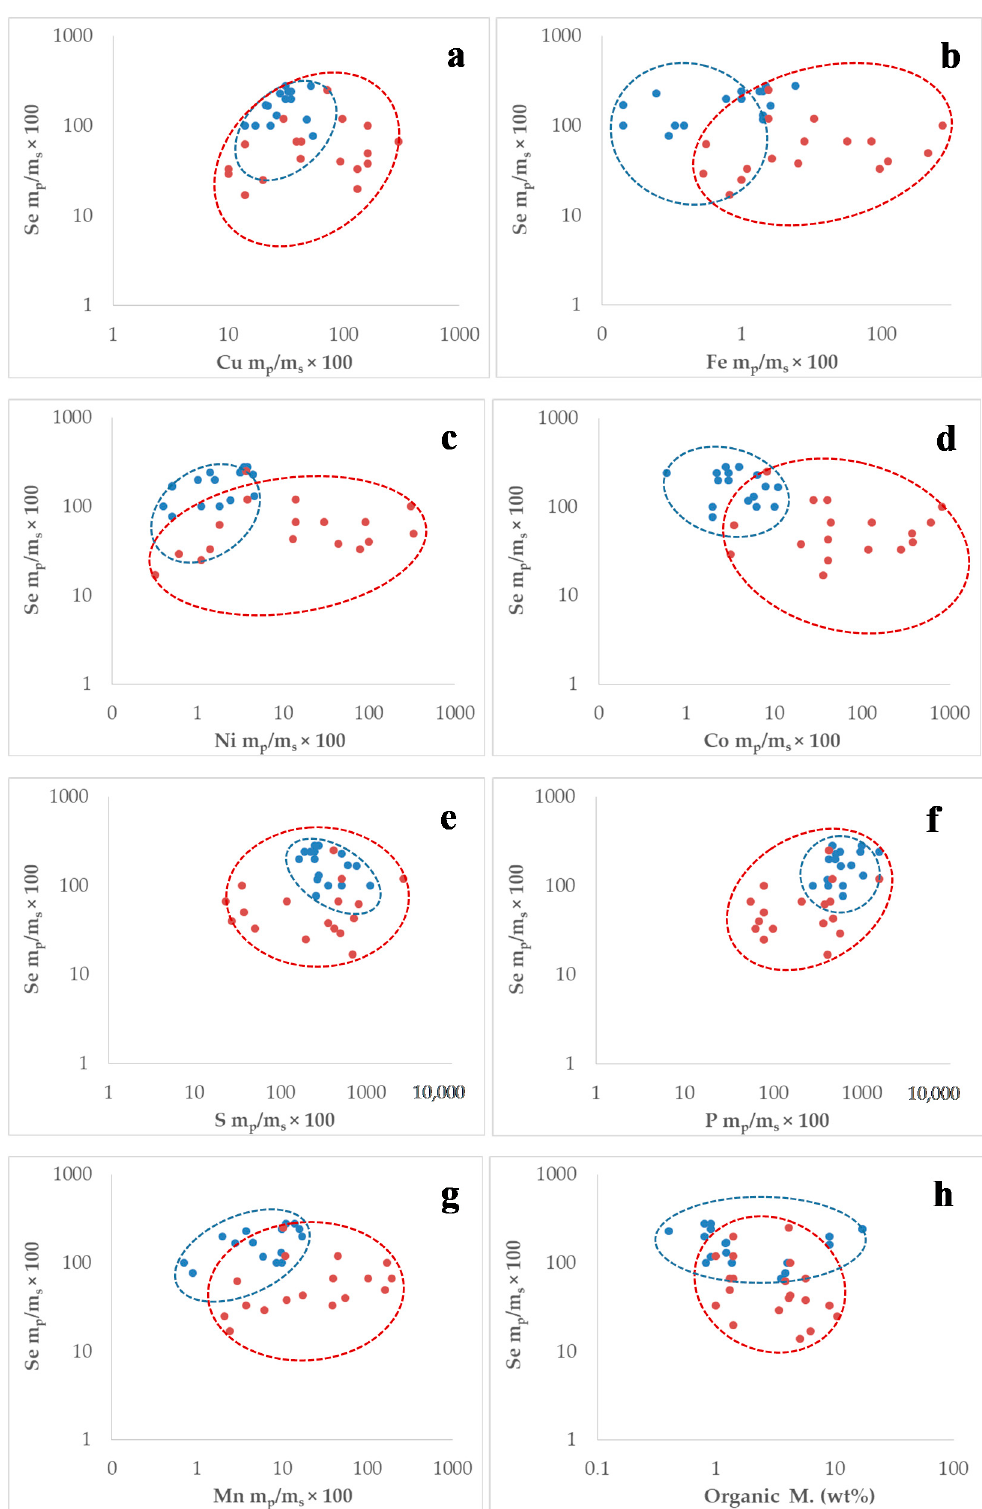
Figure 4. Plot of the percentage for Se versus that for Cu, Fe, Ni, Co, S, P, Mn and organic matter ( a – h ) in soils from the Assopos–Thiva and Attica basins. Data from Table 3.